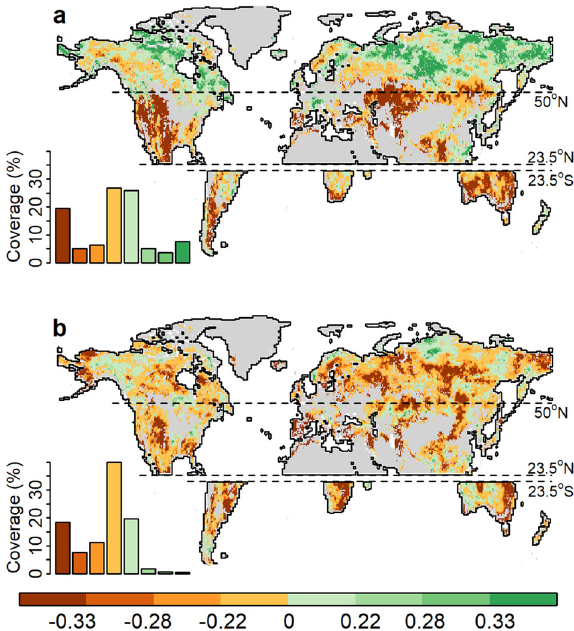
Fig. 2 Summer vegetation lagged responses to spring compound climate conditions. a Grid-based partial correlations between yearly spring CWD climate conditions and summer NDVI (a proxy for vegetation growth) during the period 1981 – 2015, computed based on partial correlation analysis (see “ Methods ” ). b The same as a , but for spring CCD climate conditions. Absolute values of the partial correlation coef fi cients ( r ) correspond to signi fi cance levels of p = 0.2 ( r = 0.22), p = 0.1 ( r = 0.28), or p = 0.05 ( r = 0.33). For each map, frequency histograms show the areal coverage corresponding to positive and negative correlations. Light gray areas, i.e. cropland, urban, barren, and permanent snow, and ice, are not included in the